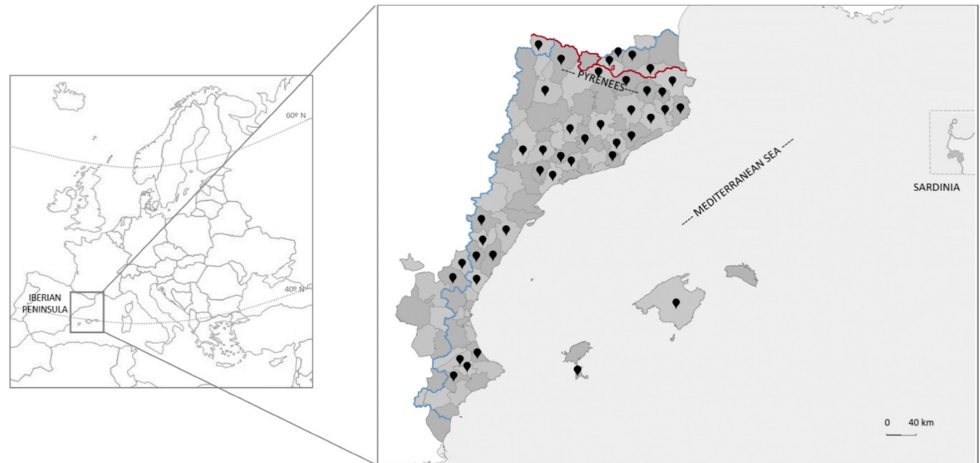
Figure 1. Territories studied (black drops) in the Catalan linguistic area and its location in Europe. The blue line defines the current zones where Catalan language is spoken and the red line the borders between states. The small subdivisions in the continental part correspond to administrative districts (called ‘ comarca’ , pl. ‘ comarques’ , in